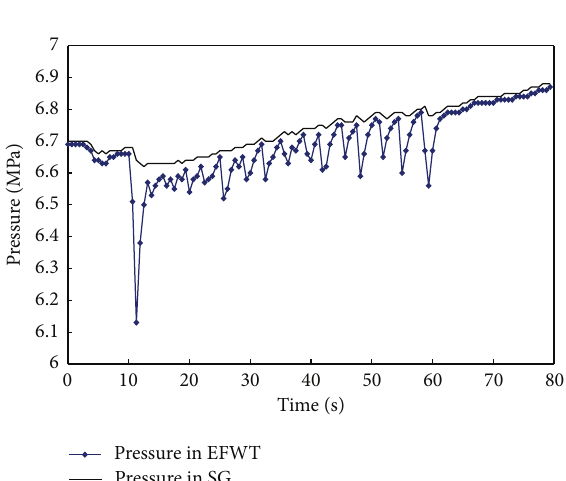
Figure 5: The feedwater flow rate.